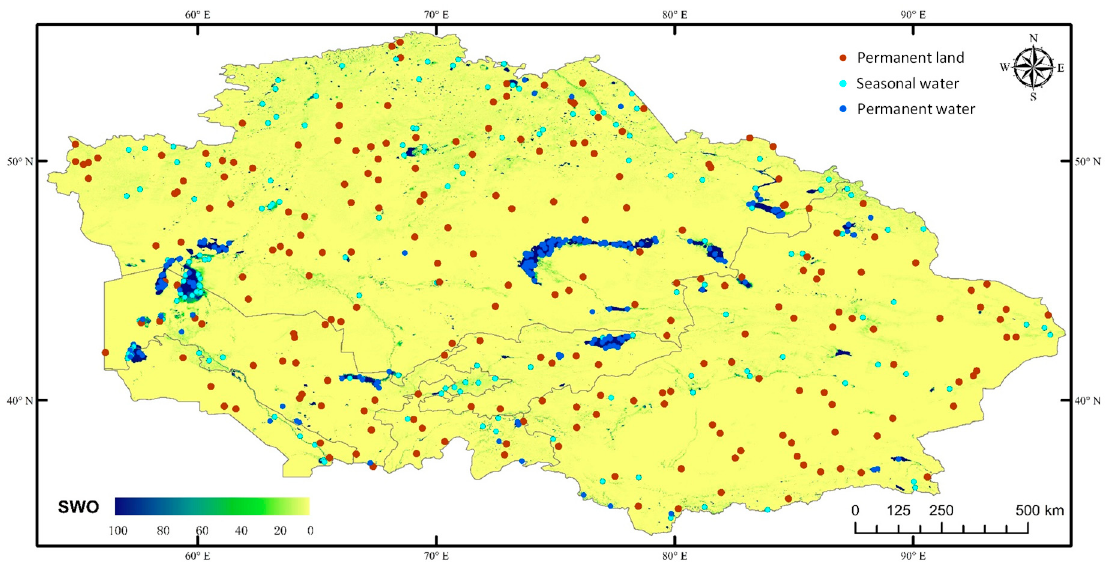
Figure 5. The spatial distribution of the collected samples for validation.